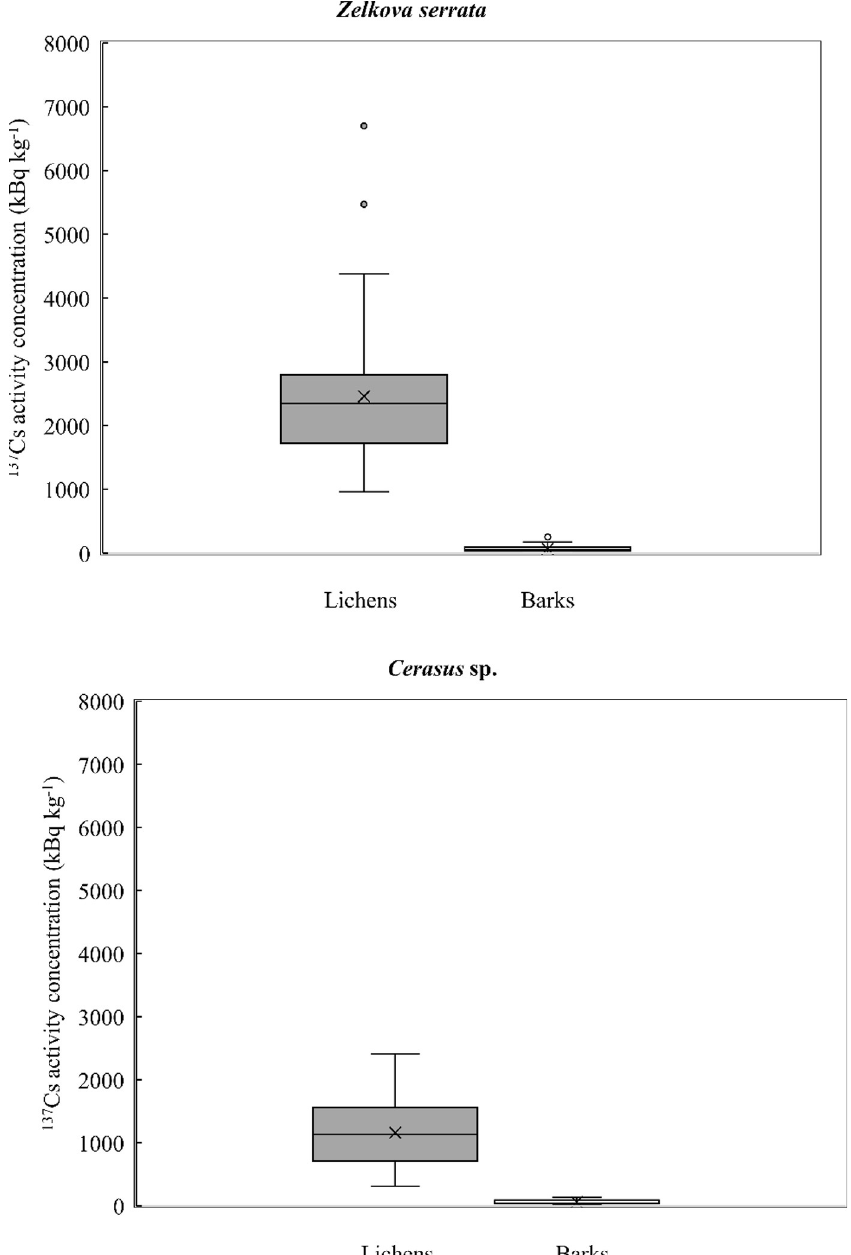
Fig 3. Comparison of 137 Cs activity concentrations of lichens and barks. (A) Zelkova serrata . (B) Cerasus sp.